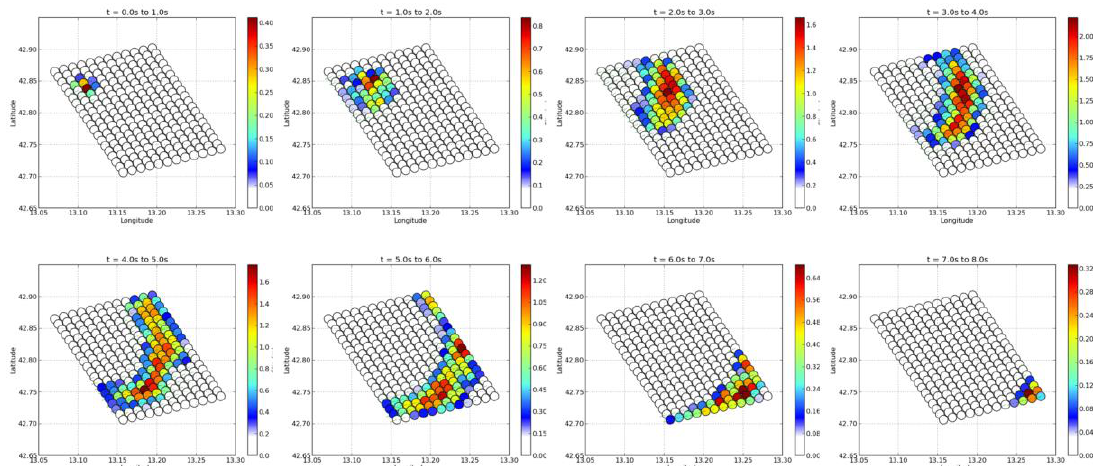
Figure A6. Rupture snapshots in a time interval of 1 s for the Norcia earthquake.